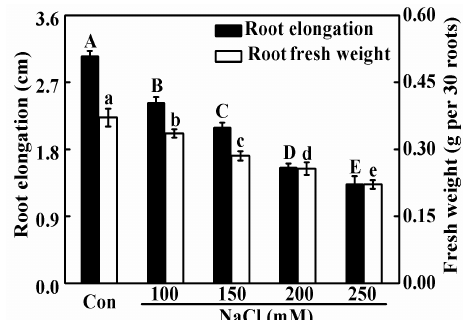
Figure 1. Growth inhibition of seedling roots upon NaCl stress. Three-day-old rapeseed seedlings were transferred to 100, 150, 200, and 250 mM NaCl for 2 days. Afterwards, the root elongation (left) and root fresh weight (right) were measured. The sample without chemicals was the control (Con). Values are means ± standard error (SE) of three independent experiments with at least three replicates for each. Bars with different letters are significant different at p < 0.05 according to Duncan’s multiple range test.